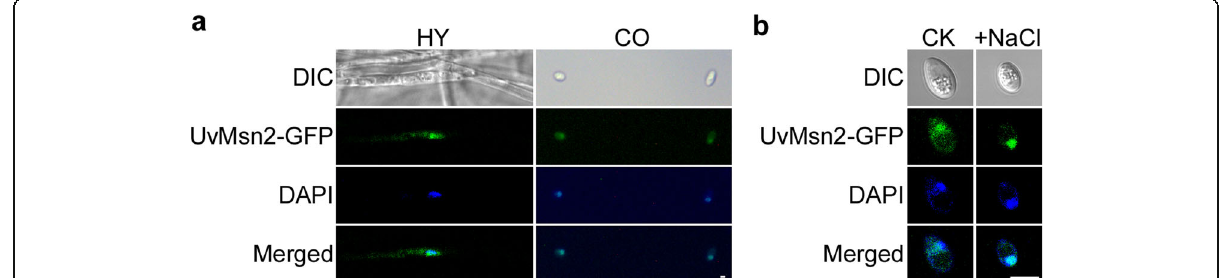
Fig. 7 Subcellular localization of UvMsn2 in Ustilaginoidea virens . a Hyphae and conidia expressing UvMsn2-GFP was stained with DAPI and examined under a confocal microscope. b Epifluorescence observation of the conidia untreated (ck) or treated with 0.4 M NaCl for 30 min. DAPI was added to the cultures 5 min before observation. Bar = 5 μ